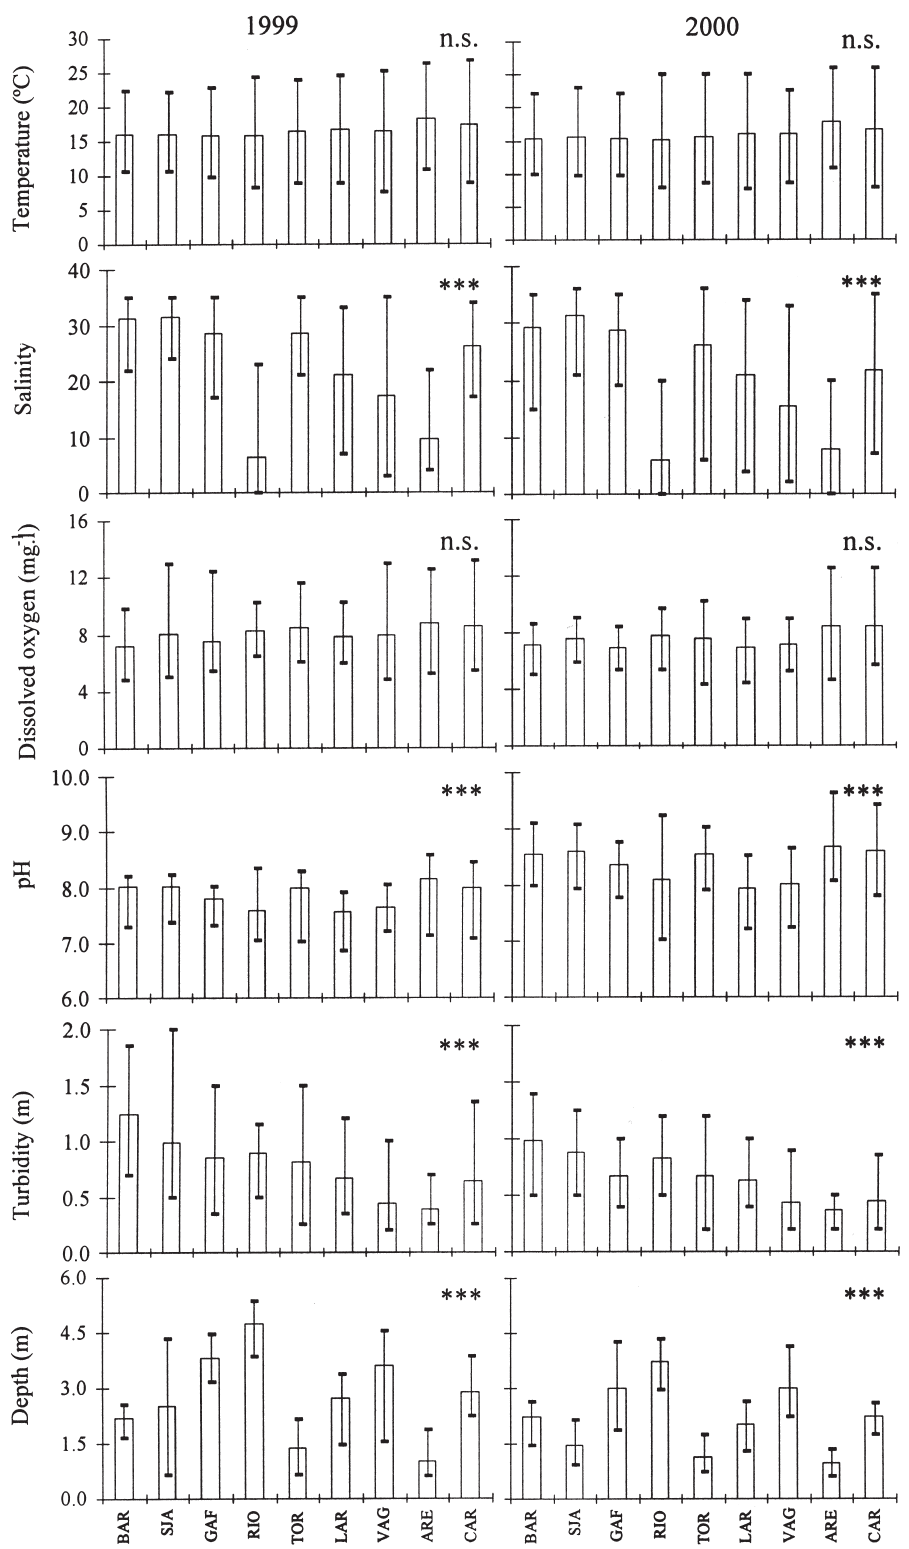
F IG . 5. – Minimum, average and maximum values of abiotic parameters by sampling sites; each column of graphs correspond to a sampling year. Site abbreviations are explained in the text and shown in Figure 1. Significant differences of abiotic parameters between sites